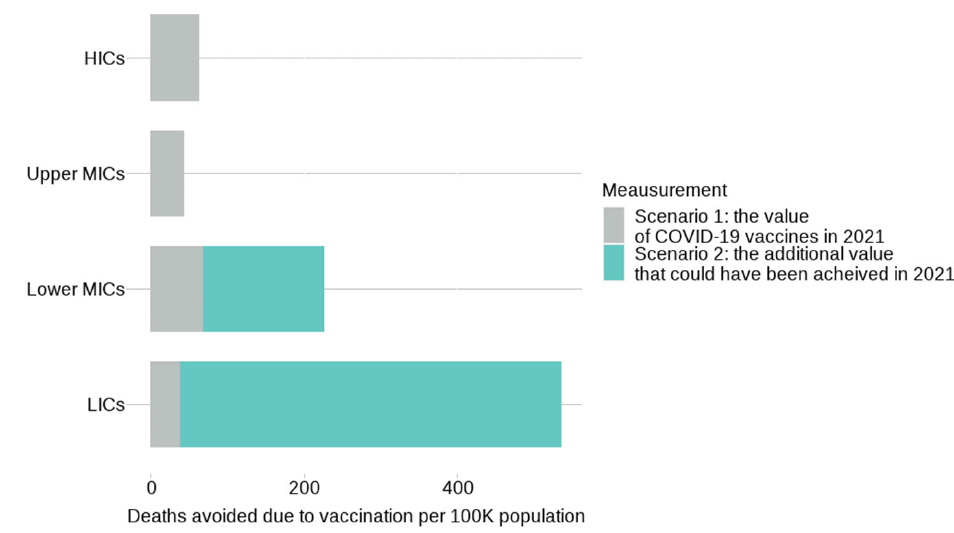
Figure 5. Excess deaths avoided due to vaccination per 100 k population per country income group.